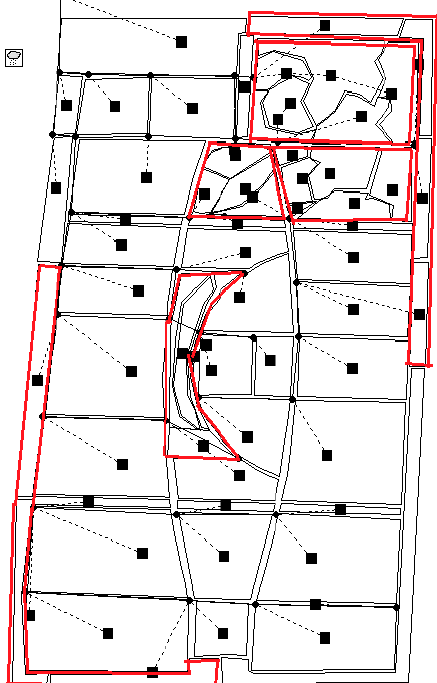
Figure 10. Slope map ( a ) and aspect map ( b ) of the study area. Hydrology 2020 , 7 , 26